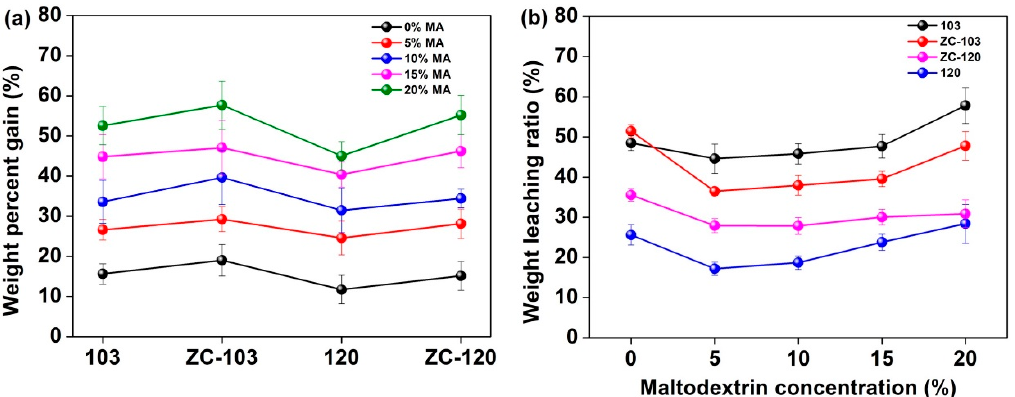
Figure 3. Weight percent gain (WPG) ( a ) and weight leaching ratio (WLR) ( b ) of wood treated with different methods and concentrations. Error bars represent the standard deviation of 20 replicates per treatment.